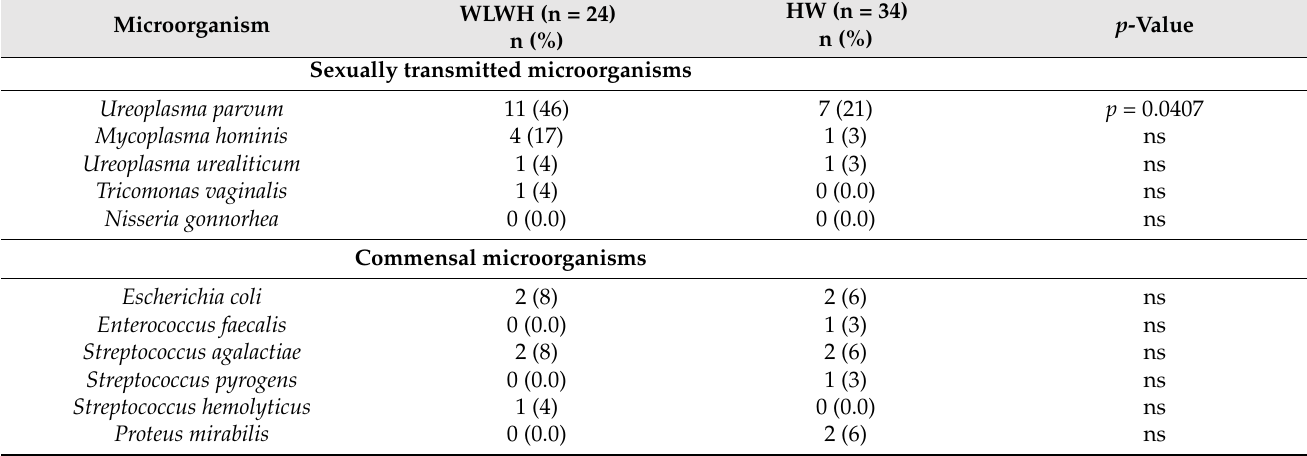
Table 3. Sexually transmitted and commensal microorganisms in the study population.